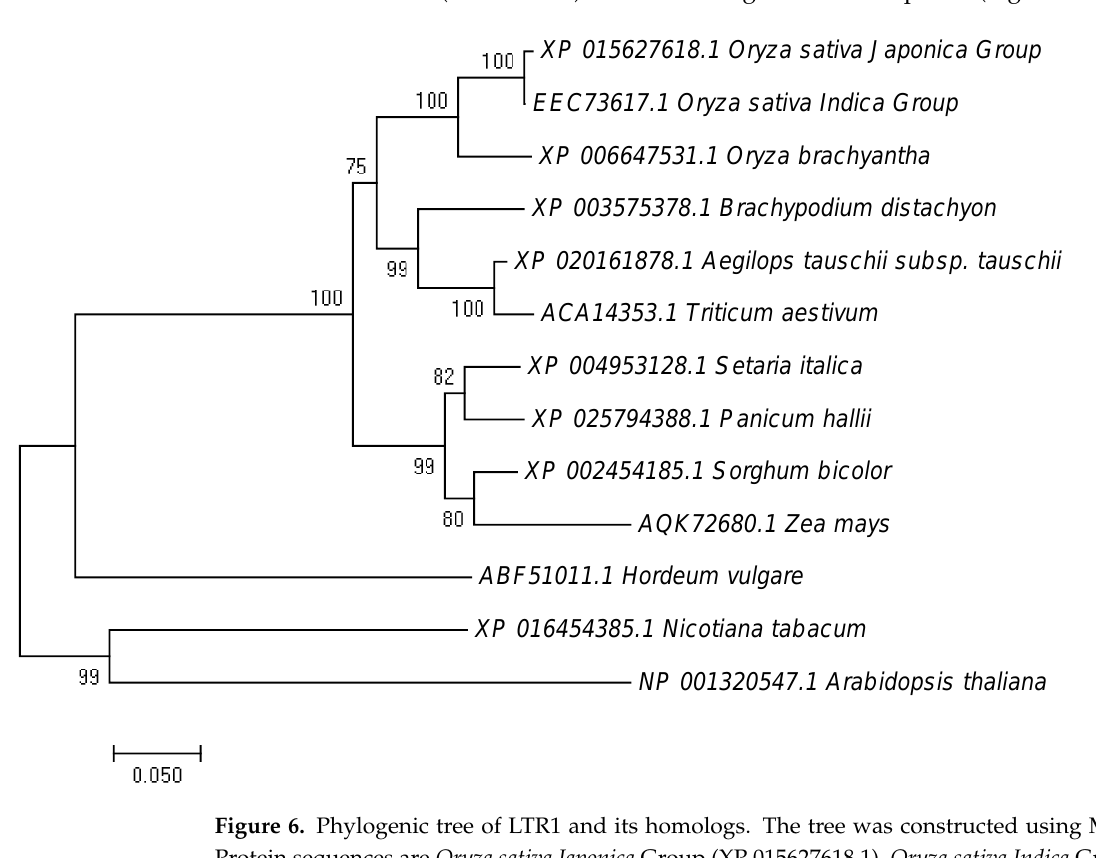
Figure 6. Phylogenic tree of LTR1 and its homologs. The tree was constructed using MEGA 7.0. Protein sequences are Oryza sativa Japonica Group (XP 015627618.1), Oryza sativa Indica Group (EEC 73617.1), Oryza brachyantha (XP 006647531.1), Brachypodium distachyon (XP 003575378.1), Aegilops tauschii (XP 020161878.1), Triticum aestivum (ACA 14353.1), Setaria italic (XP 004953128.1), Panicum hallii (XP 025794388.1), Sorghum bicolor (XP 002454185.1), Zea mays (AQK 72680.1), Hordeum vulgare (ABF 51011.1), Nicotiana tabacum (XP 016454385.1), Arabidopsis thaliana (NP 001320547.1). Scale represents percentage substitutions per site. Statistical support for the nodes is indicated.